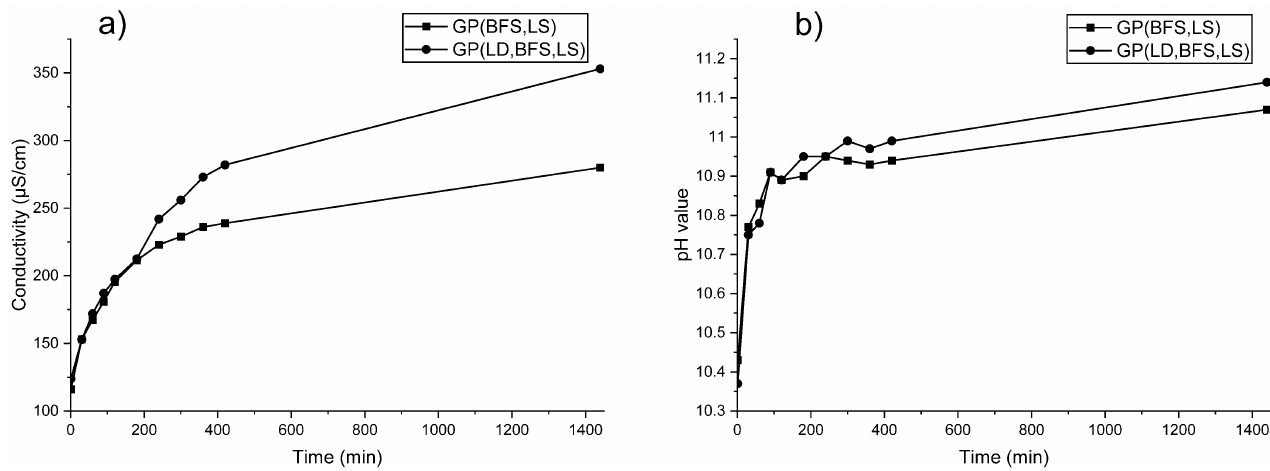
Figure 5. Conductivity value ( a ) and pH values ( b ) of GP (BFS, LS) and GP (LD, BFS, LS) as a function of time during 24 h leaching.